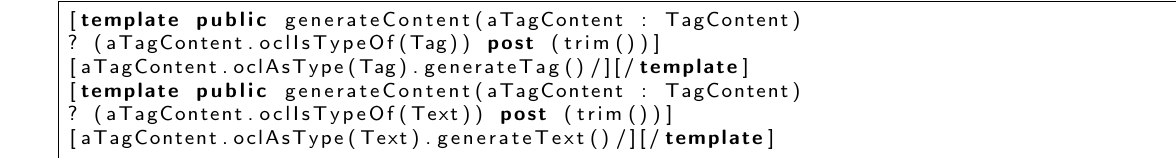
Figure 11. Template for generating the content of an XML tag in